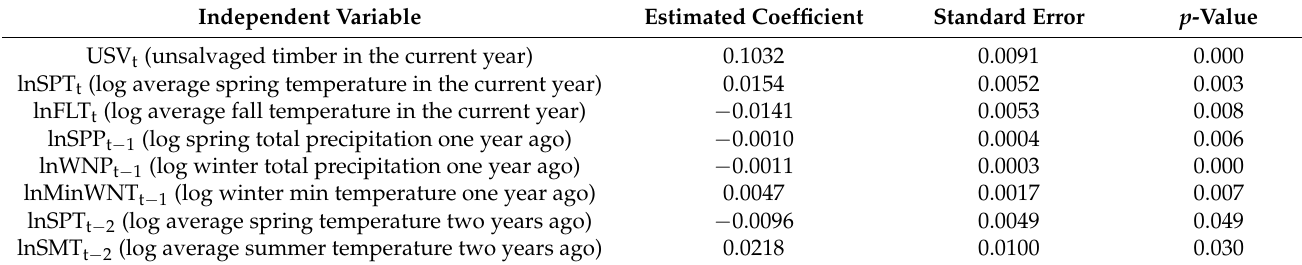
Table 1. Statistical relationship between the southern pine beetle (SPB) infestation risk and climatic and other